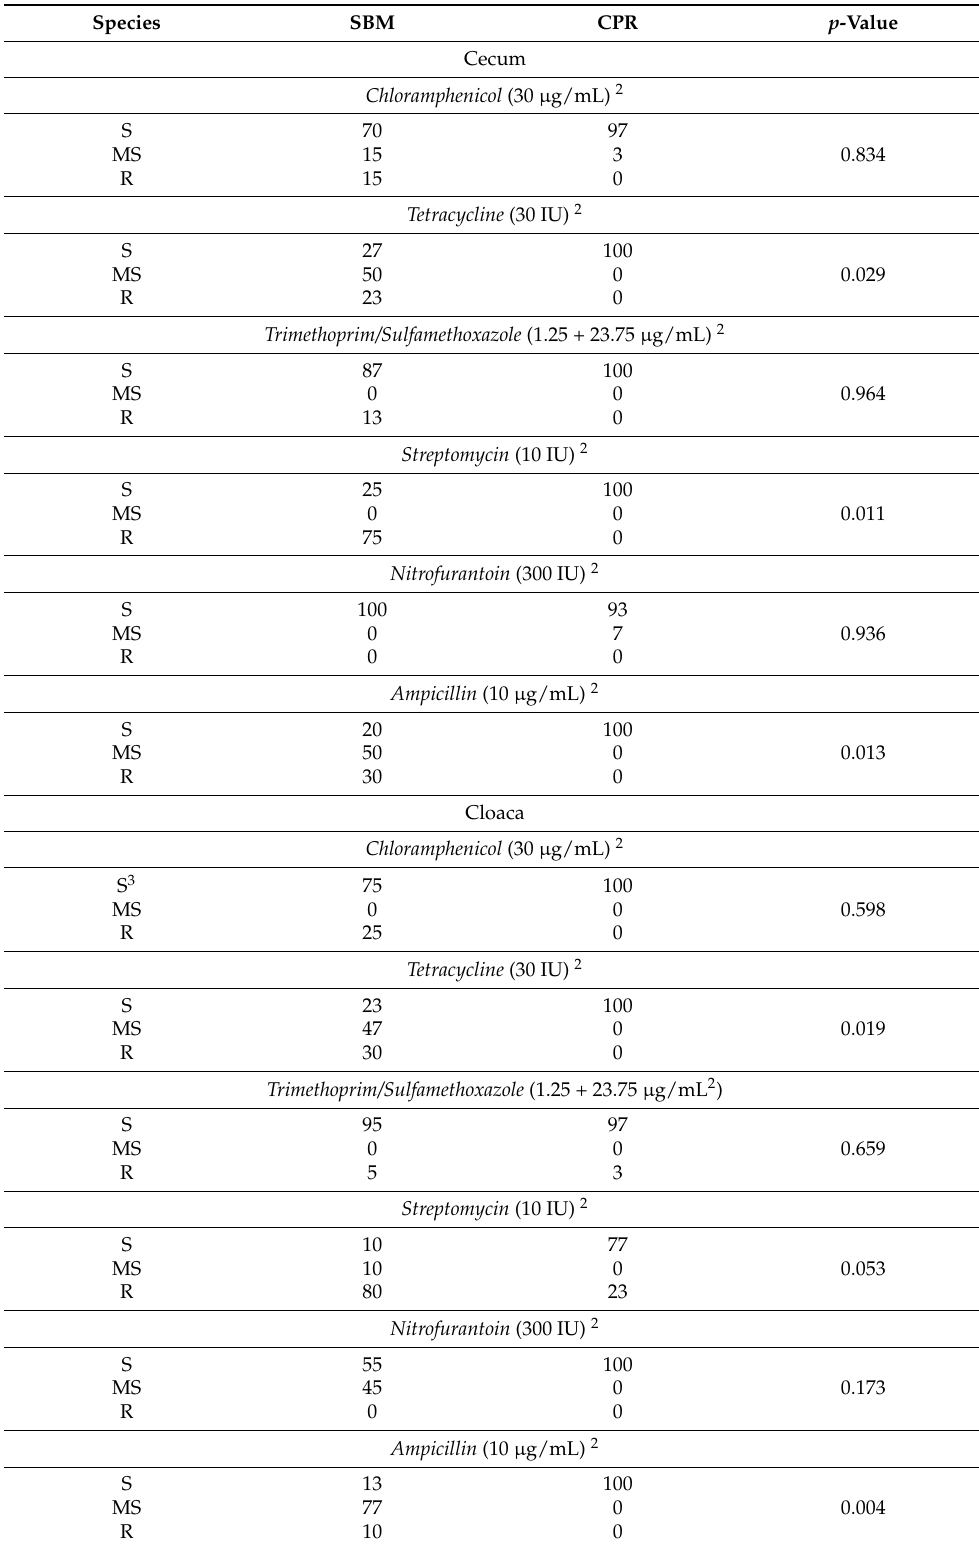
Table 8. Sensitivity of Enterobacteriaceae strains isolated from the cecum and cloaca of broiler chickens at day 42 to chemotherapeutic agent percentage 1